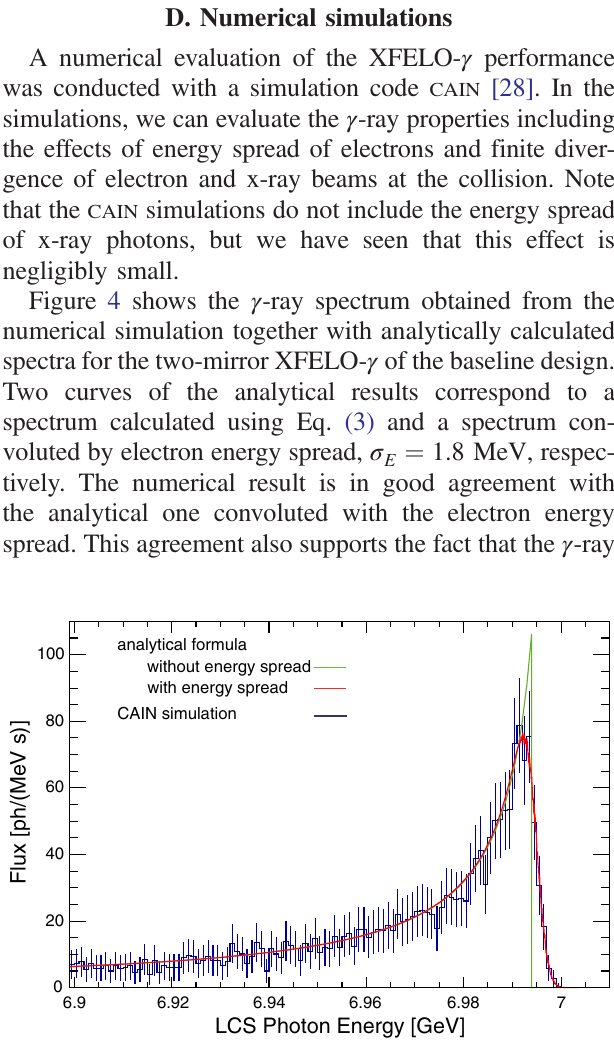
FIG. 4. γ -ray spectra of the two-mirror 7-GeV XFELO- γ calculated by an analytical formula without electron energy spread (green) and with energy spread (red), and numerical simulation by CAIN